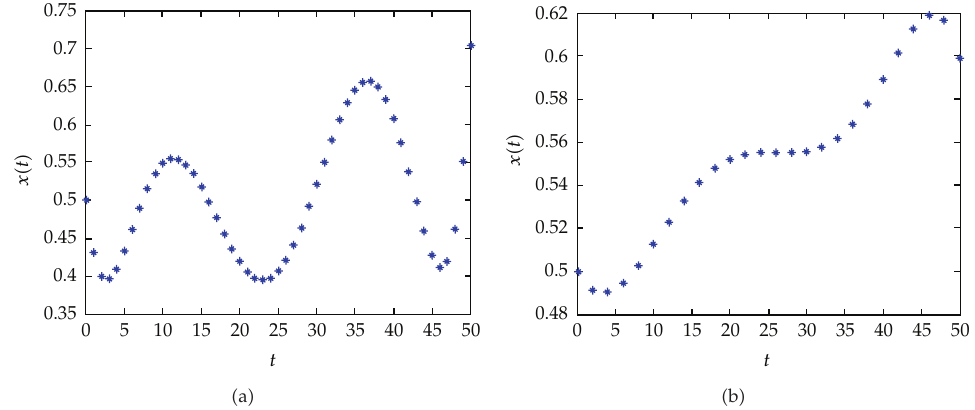
Figure 3: The behavior of the numerical solution (cid:3) at α (cid:8) 0 . 85 ,ρ (cid:8) 0 . 5 (cid:4) using ChebM with (cid:3) m (cid:8) 6 (cid:4) at r 1 (cid:8) 0 . 0, r 2 (cid:8) 0 . 7 (cid:3) a (cid:4) and r 1 (cid:8) r 2 (cid:8) 0 . 7 (cid:3) b (cid:4)